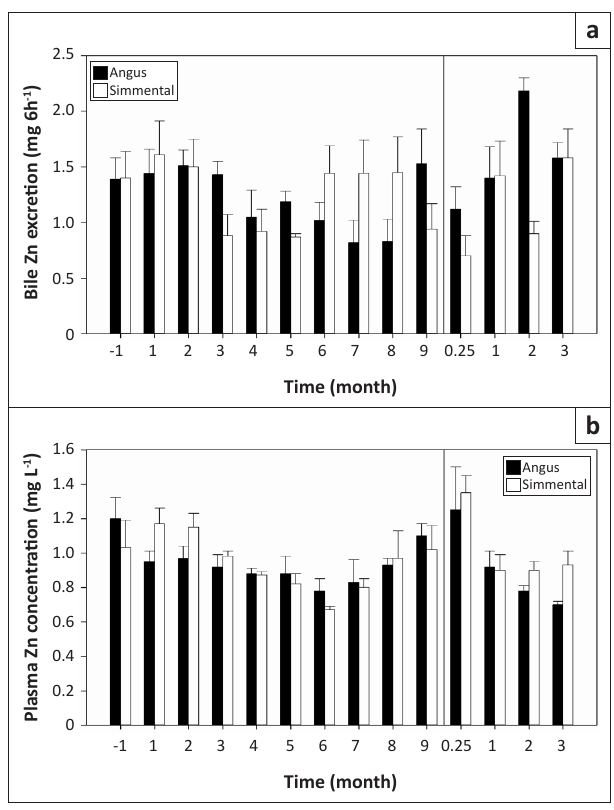
FIGURE 2: Bile zinc excretion and plasma zinc concentration profiles in Simmental and Angus cattle prior to, during and following pregnancy.